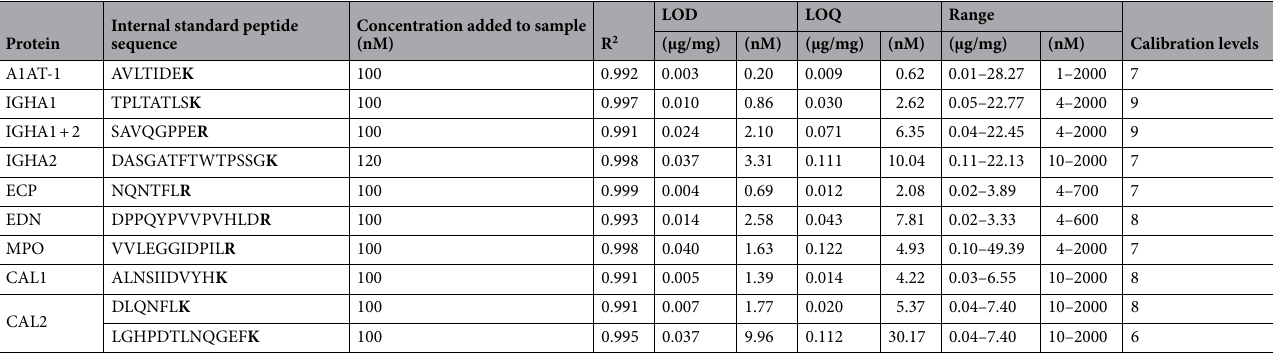
Table 2. The validation parameters of assessed proteotypic peptides, i.e., the linearity of response, assay range, LOD, and LOQ. All concentrations in (nM) for peptide surrogates and in (ug/mg) for target protein in total protein (by BCA) . The position of stable isotope-labeled arginine (R*; 13 C 6 H 14 O 215 N 4 ; + 10 Da mass shift) or lysine (K*; 13